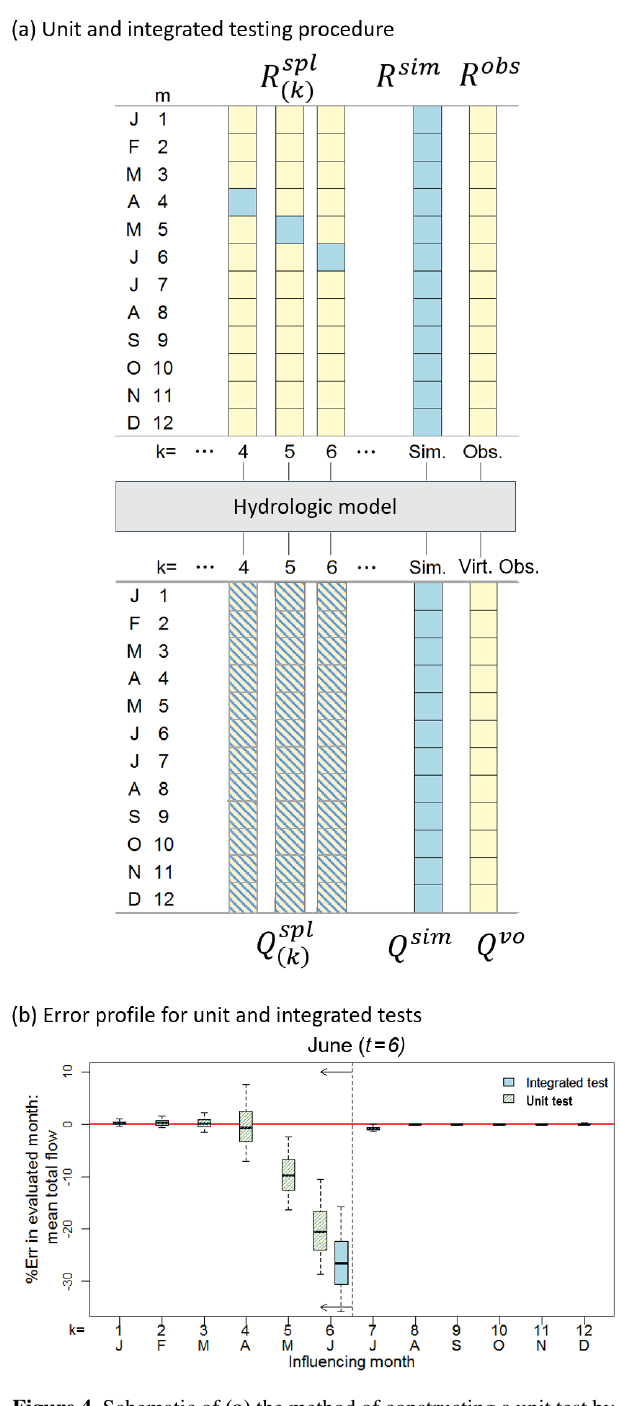
Figure 4. Schematic of (a) the method of constructing a unit test by embedding simulated months in an observed time series and (b) the error profile produced when using the integrated and unit tests for the evaluated time period of June ( t = 6) (boxplot whiskers indicate the 90% limits of the simulated streamflow replicates). For the unit test the errors in the evaluated period ( t ) are calculated as the differ- ence between Q spl and Q vo . For the integrated test the errors are (k) (t) calculated as the difference between Q sim and Q vo (t)